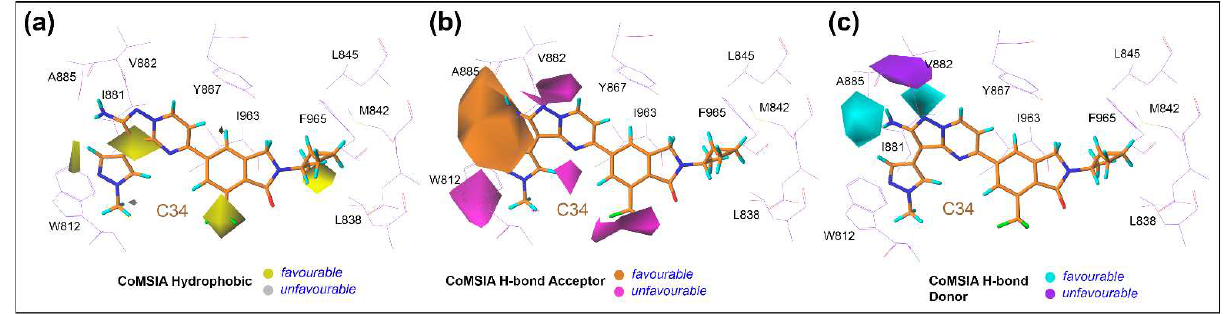
Figure 9. The standard deviation of coefficient contour maps of PI3Kγ CoMSIA model. In Figures ( a – c ), the contour maps indicate the favorable and unfavorable substitution of hydrophobic, H-bond acceptor, and H-bond donor groups over compound C34.